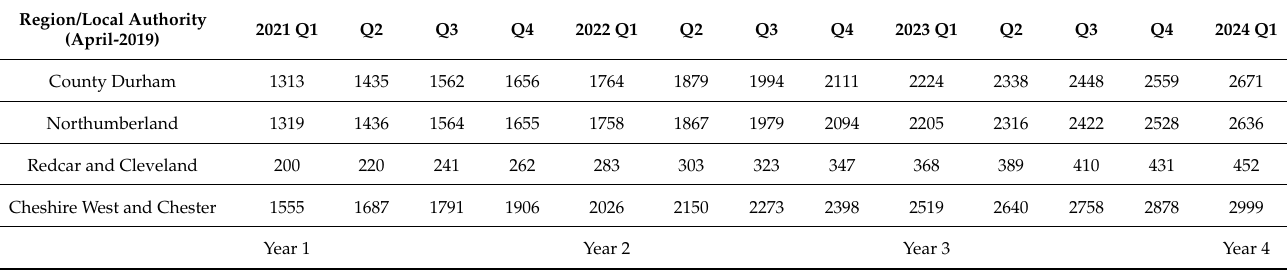
Table 12. Selection of forecasted data per quarter.